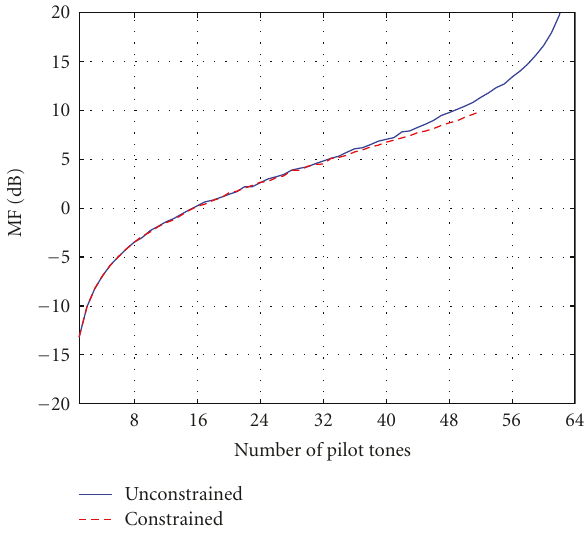
Figure 8: MF values of the synchronization